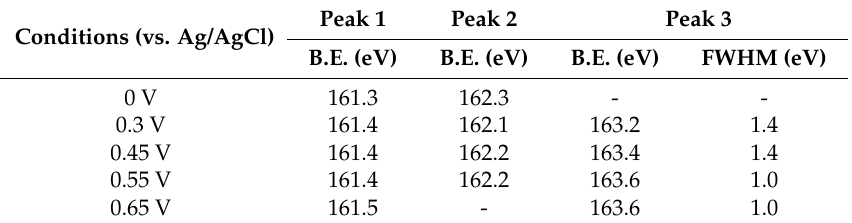
Table 5. Binding energy and FWHM value for XPS spectra of S 2p 3/2 peaks of bornite after treating by different potential of 0, 0.3, 0.45, 0.55, 0.65 V, respectively (Implemented on the model of ESCALAB 250Xi of Al Kα X-ray source with 20 eV constant pass energy and 0.1 eV/step; Fitted by Thermo Avantage 5.52, C 1s 284.8 eV as reference, Shirley method, Gaussian-Lorentzian function) (FWHM means full width at half maximum, B.E. means binding energy value).